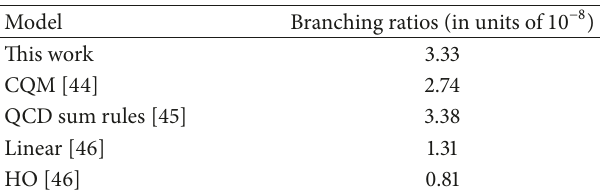
Table 2: Branching ratio for 𝐵 + 푐 → 𝐷 + ]] decay in LCQM and its comparison with the other models.